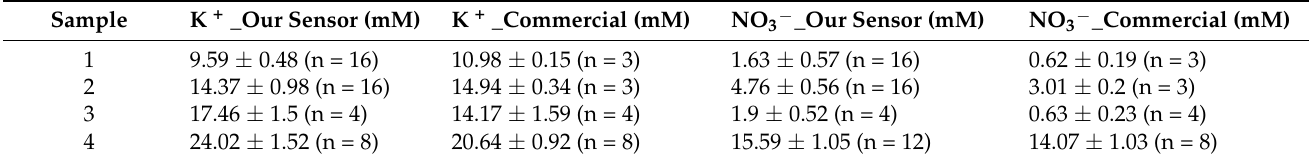
Figure 7. Xylem sap test: ( A ) Real-time sensor response in a programmed sequence of pump (P) and valves (V1,V2). The sensors were calibrated before and after each sap measurement with KNO 3 (1 and 10 mM) + NaCl. ( B ) Comparison of ion concentrations in original sap between our sensors and commercial ISEs. Sap samples were prediluted 10 × with 1 mM KNO 3 (+ 10 mM NaCl) for our sensor and 10–20 × for commercial ISEs. Table 1. Concentrations of K + and NO 3 − ions in xylem sap ( Z. mays ) measured by our sensors and commercial ISEs (n is the number of